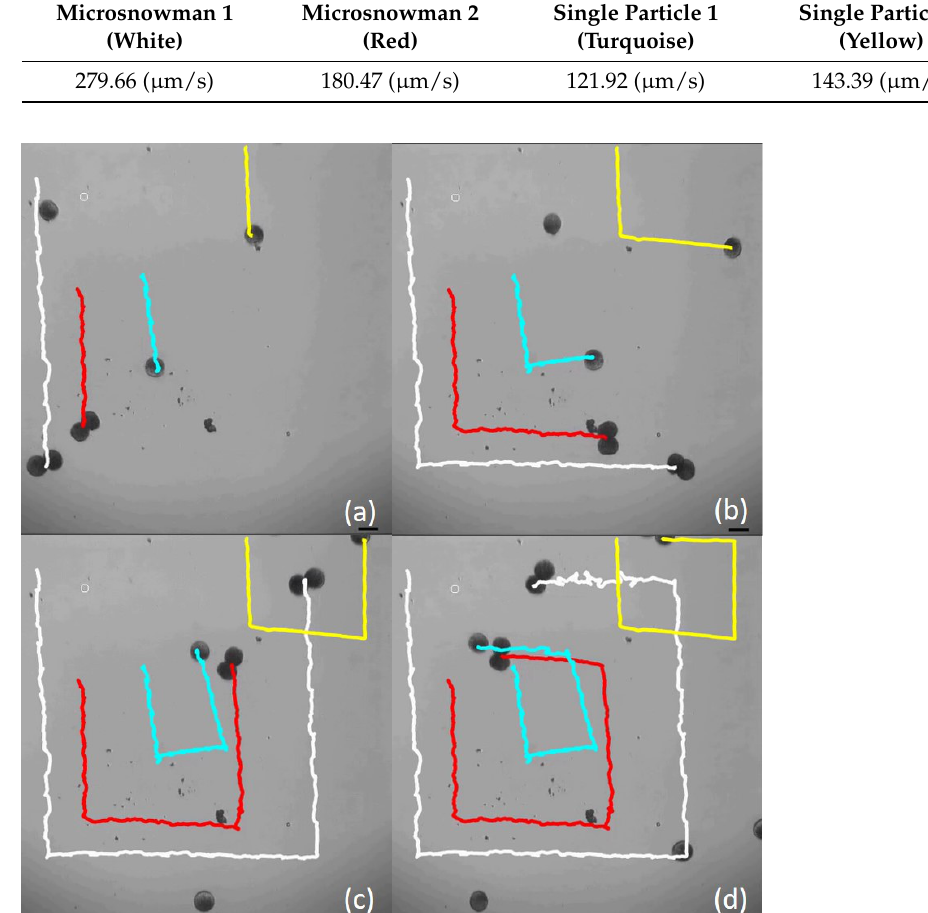
Figure 5. Swarm control of soft microsnowmen and single alginate microrobots. In frames from ( a – d ), the translation distances are shown for a rectangular path. The scale bar is set to 100